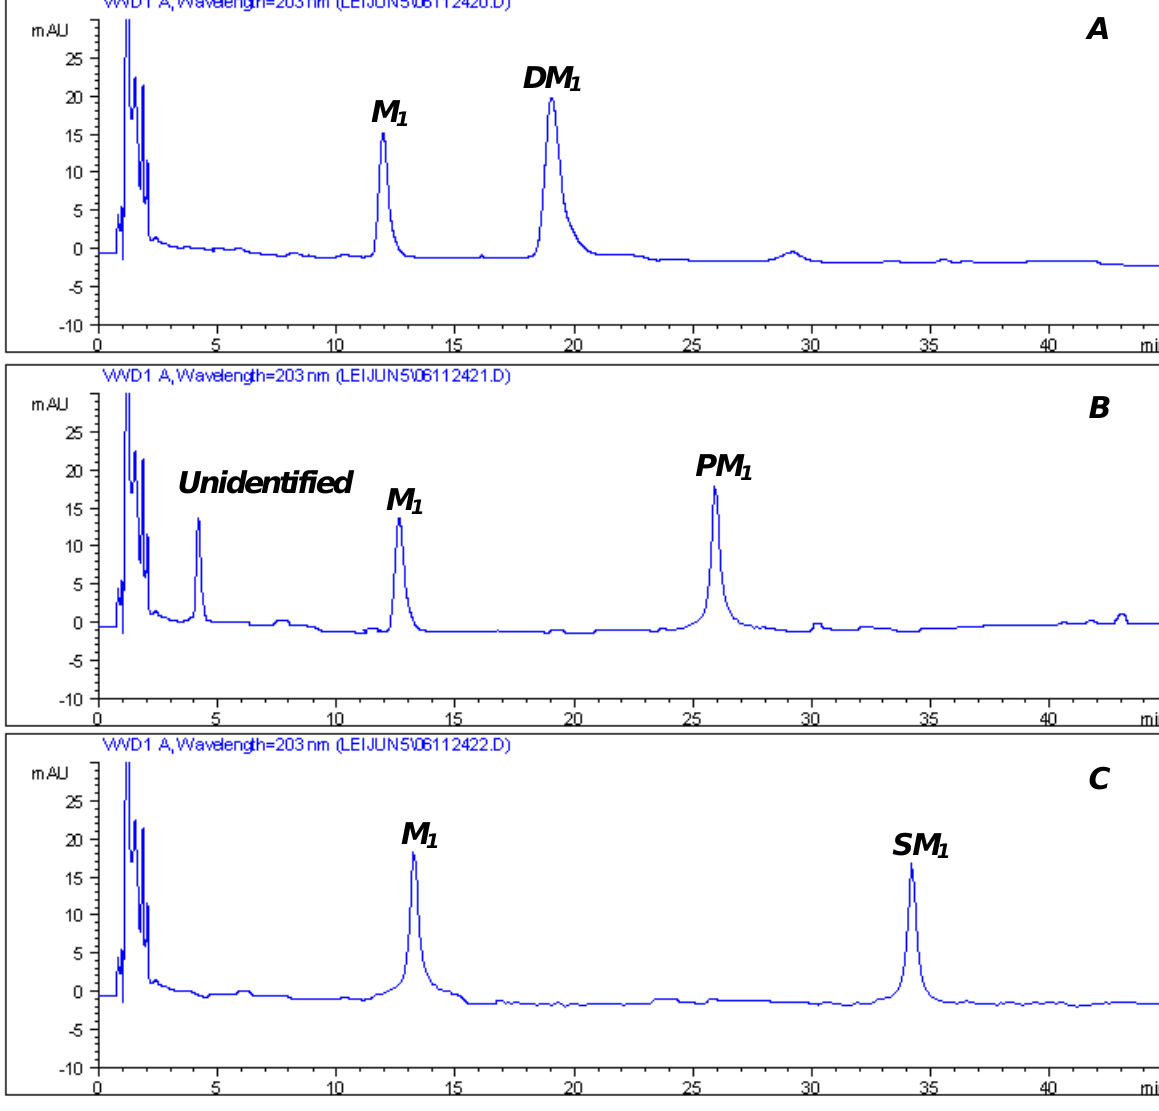
reacted with palmitoyl chloride; C : M 1